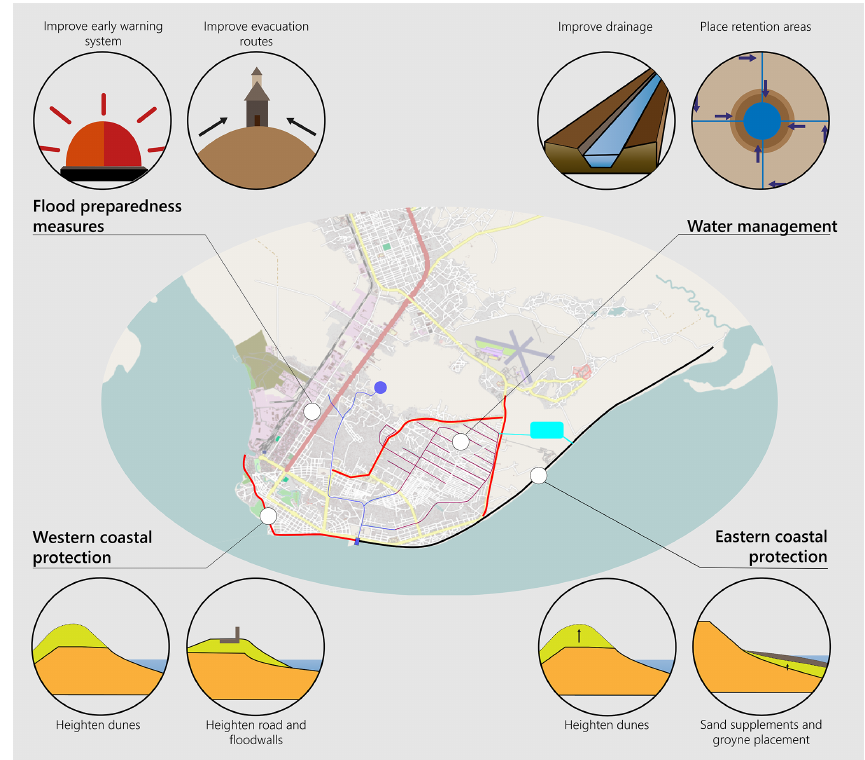
Figure 4. Map of Beira, Mozambique. Denoted are a few examples of flood risk reduction measures. Background image: © OpenStreetMap contributors 2018. Distributed under a Creative Commons BY SA